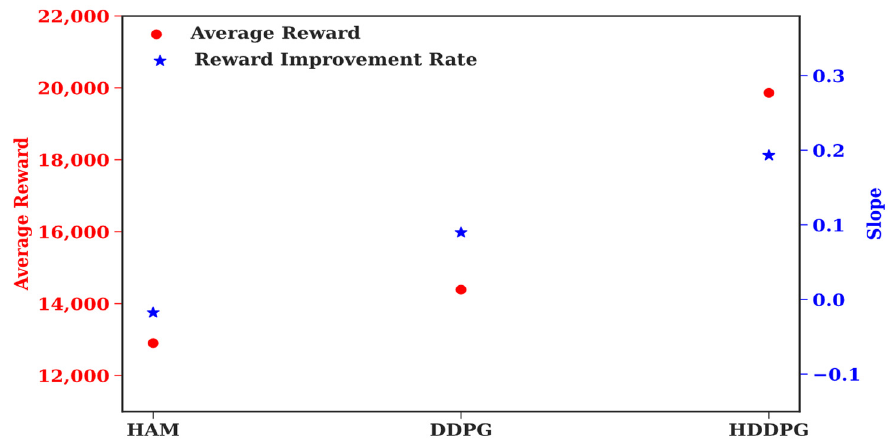
Figure 9. Comparing the average total reward (red dot) and its trend slope (blue star) of the HAM,